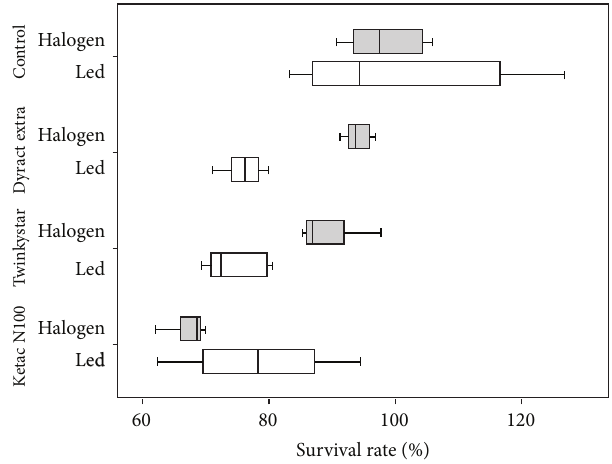
Figure 1: Cytotoxicity of resin-modified glass inomer cement and compomers cured with halogen and LED light curing units. Data are expressed as percentage of the negative control cultures ( 𝑛 = 12